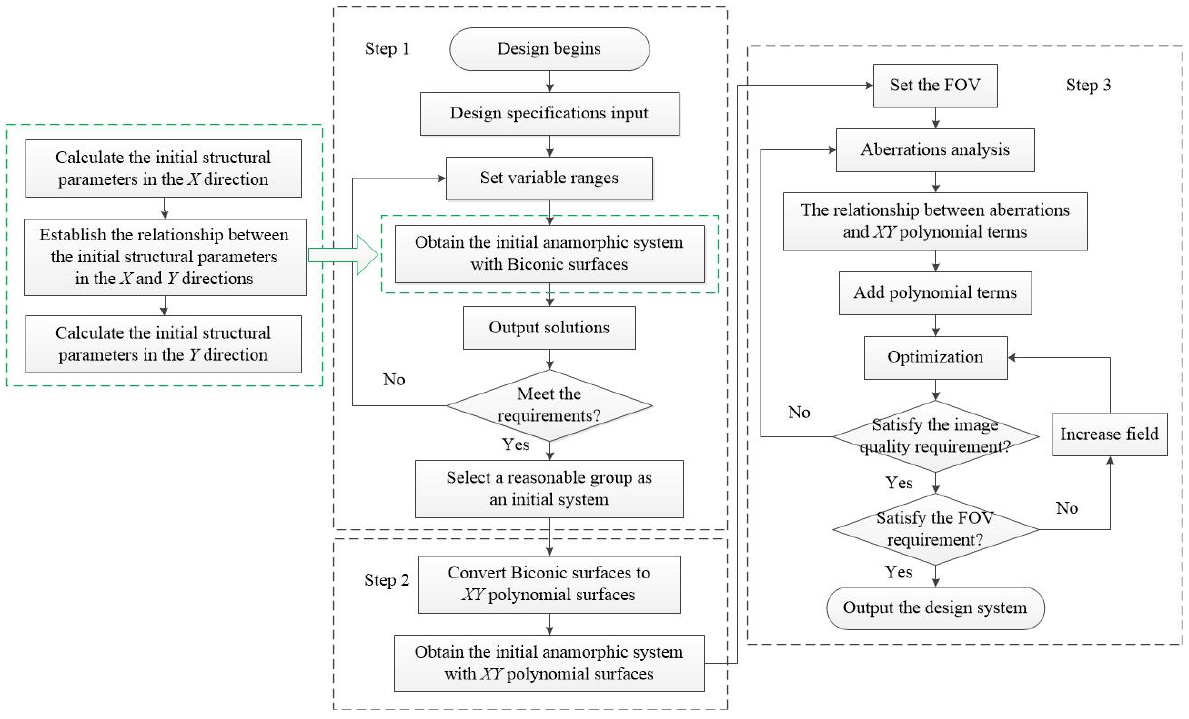
Figure 4. Flow chart of design method of freeform anamorphic systems with ultrawide FOV.